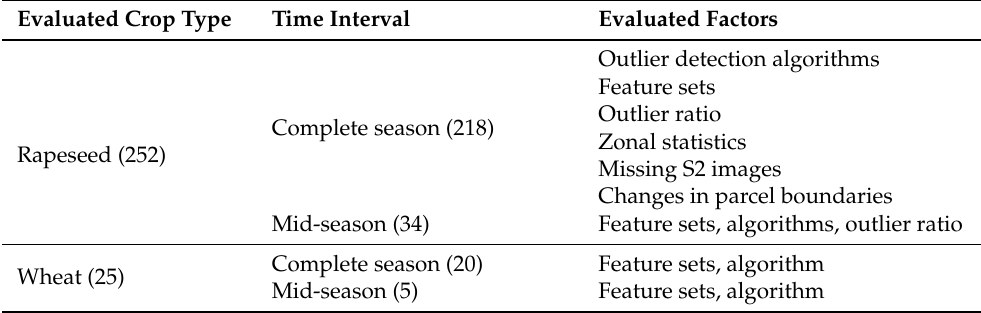
Table 4. Summary of the evaluated factors analyzed throughout the study. In parenthesis, the number of different initial configurations tested (features, algorithm, time interval, outlier ratio).